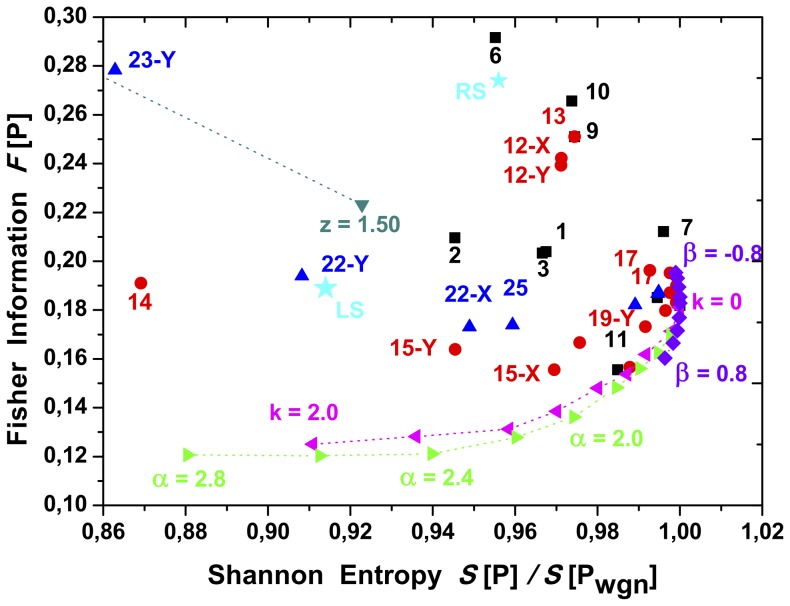
Shannon-Fisher plane,  zoom, see Fig. 9.